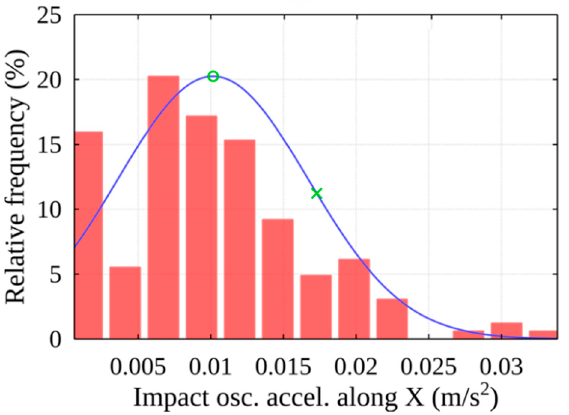
Figure 17. Histogram of peak amplitudes of acceleration along X-axis. Using the obtained acceleration threshold value, the peaks with amplitudes higher than the threshold value are selected from the sample of peaks, thereby identifying the peaks that indicate potential events (see Figure 18), marked with red crosses. Using the developed algorithm, potential events are grouped, resulting in separate shock events, and their beginnings are marked with red circles.